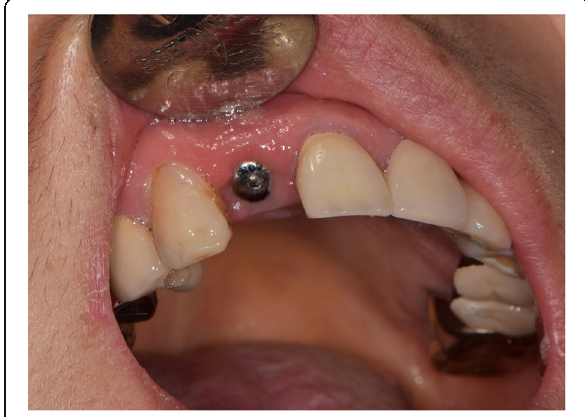
Fig. 1 Buccal aspect of the implant (#12) treated with air-powder abrasive to manage